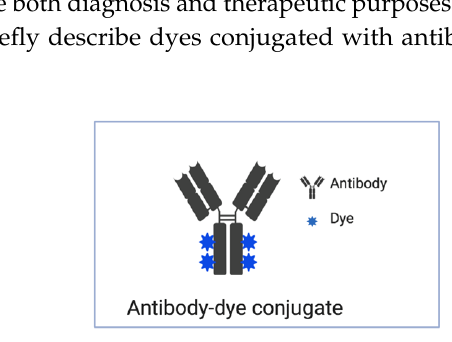
Figure 3. Schematic of possible antibody-dye conjugates obtained after labeling an antibody with dyes. Table 2. Fluorescent-labeled antibodies used in molecular imaging of gastric tumors. Cetuximab failed as a first-line therapy in GC (EXPAND clinical trial). The anti-MG7 and anti-VEGF antibodies used in the studies [19] and [20] were produced in the laboratory or obtained from commercial sources.